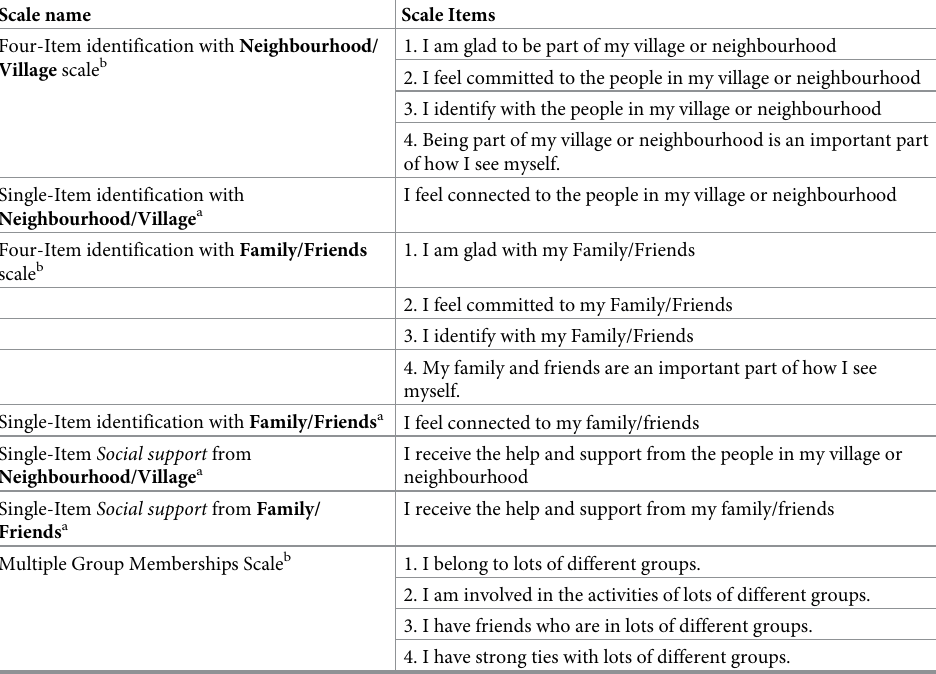
Table 1. Measures used in Study